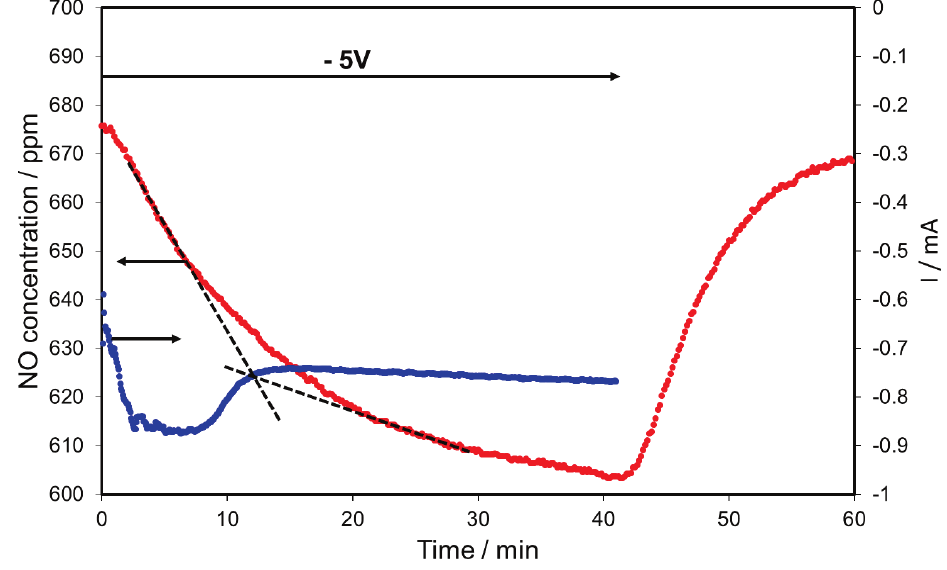
Figure 6. Variations of NO concentration and the current as a function of time at 450 ◦ C. Reactive mixture: NO/NO 2 : 680 ppm/10 ppm in